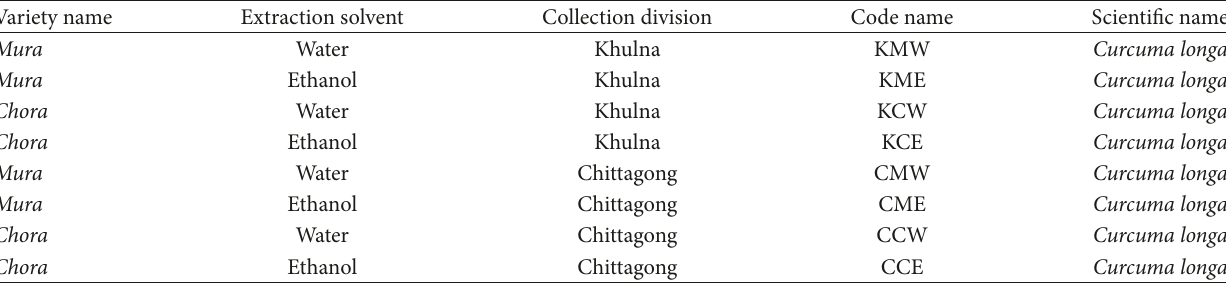
Figure 1: Turmeric varieties: (a) Kopil moni mura, (b) Kopil moni chora, (c) Chittagong mura, and (d) Chittagong chora. Table 1: Details of the eight turmeric extracts collected from Khulna and Chittagong